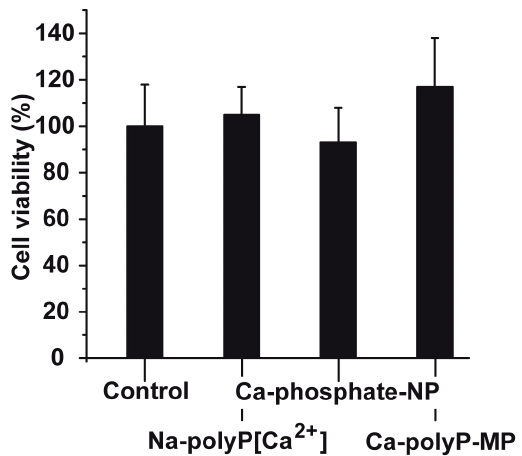
Figure 3. Viability of PC12 cells seeded into 48-well plates for a period of 72 h. Cell viability was determined using the MTT (3-[4,5-dimethyl thiazole-2-yl]-2,5-diphenyl tetrazolium) assay. The concentrations of Na-polyP[Ca 2+ ], Ca-phosphate-NP and Ca-polyP-MP in the assays were identical (30 µ g/mL); the controls did not contain additional phosphate or polyP. Data represent mean ± SD of ten independent experiments; no significant differences are calculated ( p > 0.05).